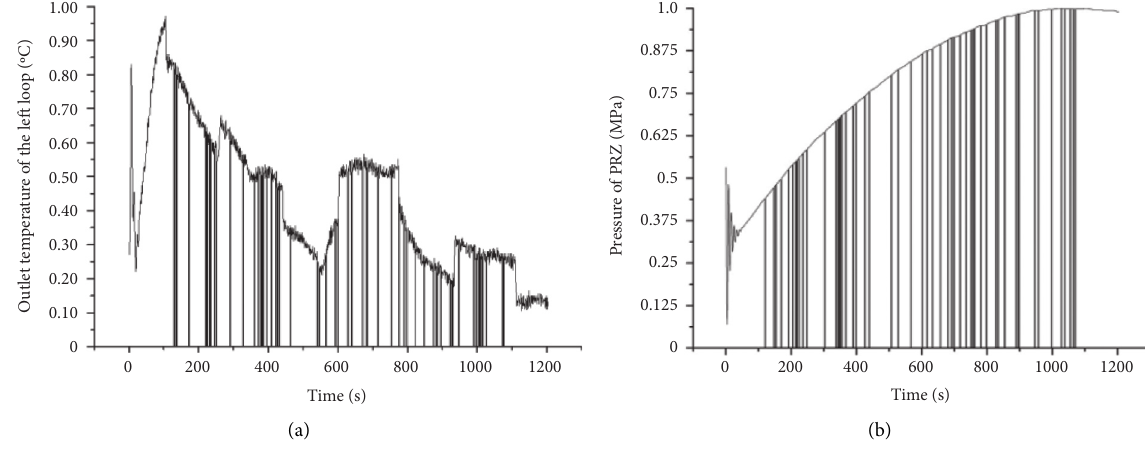
Figure 6: The curves of parameters after setting missing